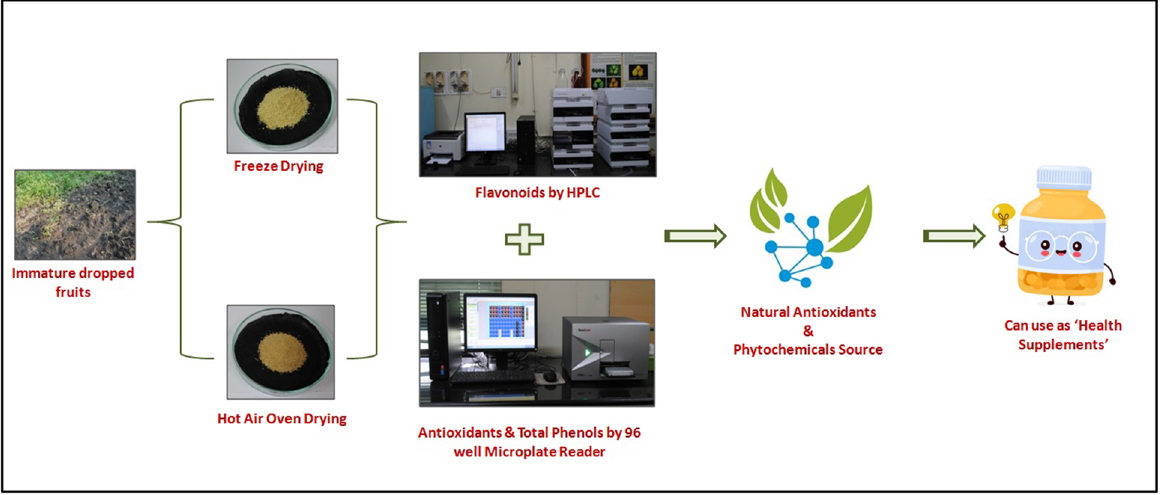
Figure 8. Graphical abstract of the